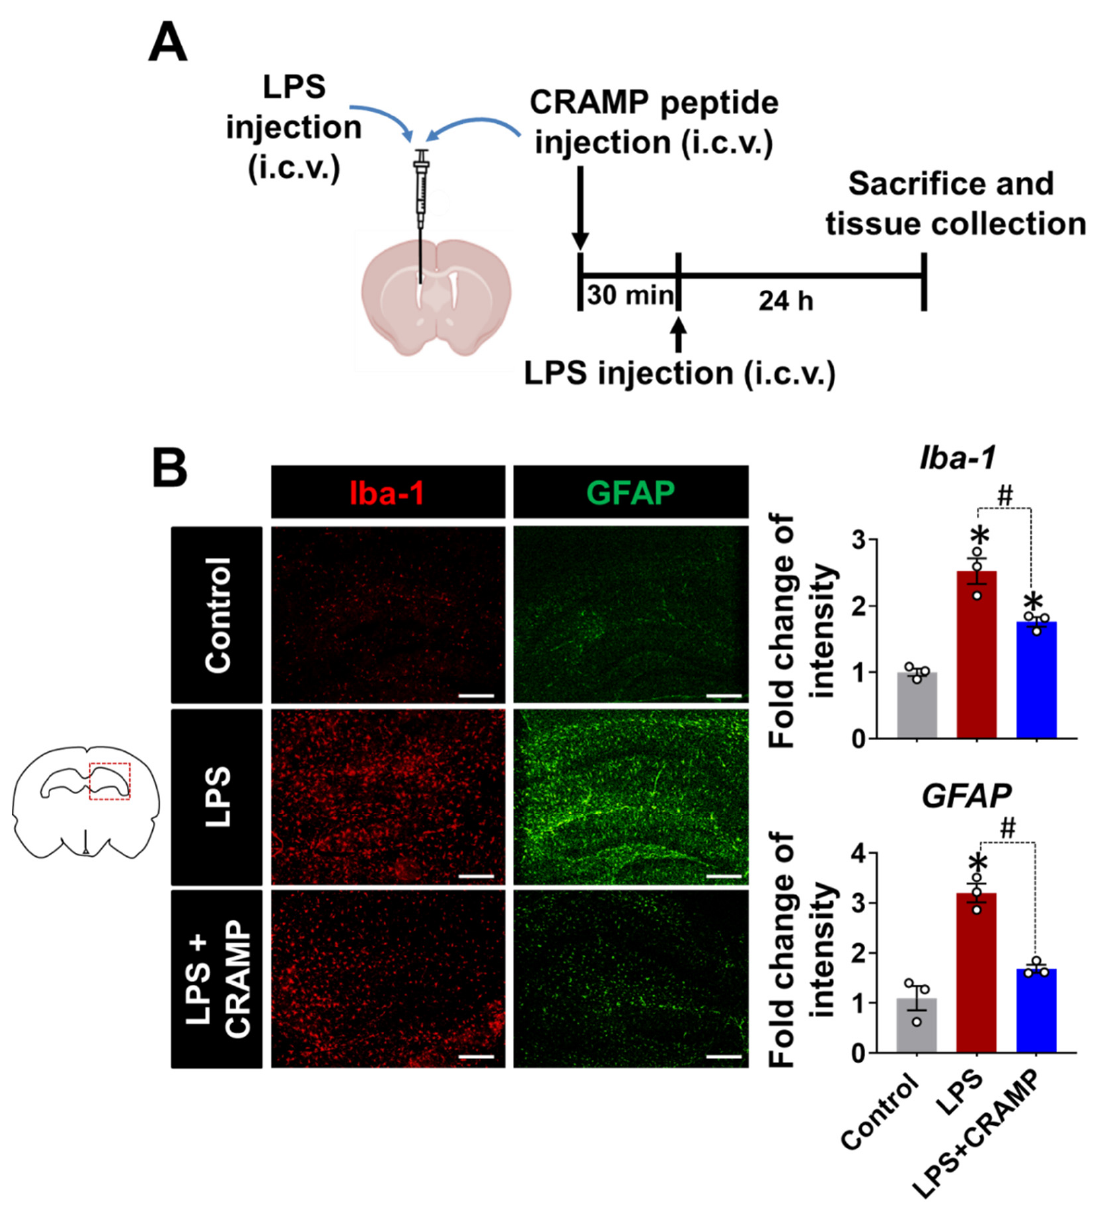
Figure 6. CRAMP peptide administration suppresses LPS (i.c.v.)-induced gliosis in mouse brain. ( A ) Scheme of the experimental timeline with the routes of CRAMP peptide and LPS administrations. ( B ) The hippocampal region of the mouse brain sections was stained with GFAP or Iba-1 antibodies. Scale bars indicate 400 µm. The adjacent graphs represent the quantitative analysis of the immuno- reactivity of glial cells. Data are mean ± SEM; n = 3; * p < 0.05 versus control animals; # p < 0.05 between the specified groups. One-way ANOVA with Tukey’s post hoc test. i.c.v.,